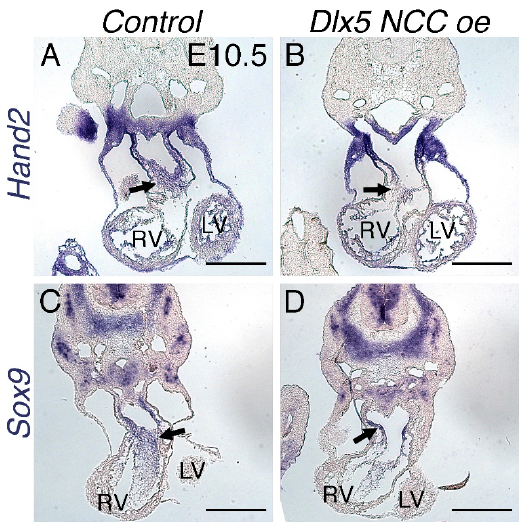
Figure 6. Expression of the OFT markers Hand2 and Sox9 is reduced within Dlx5 NCC oe embryos. ( A , B ) In situ hybridization showing expression of Hand2 within control ( A ) and Dlx5 NCC oe ( B ) E10.5 embryo hearts. ( C , D ) E10.5 control ( C ) and Dlx5 NCC oe ( D ) embryos showing Sox9 mRNA expression. Arrows denote cardiac NCC. Scale bars = 250 µm.